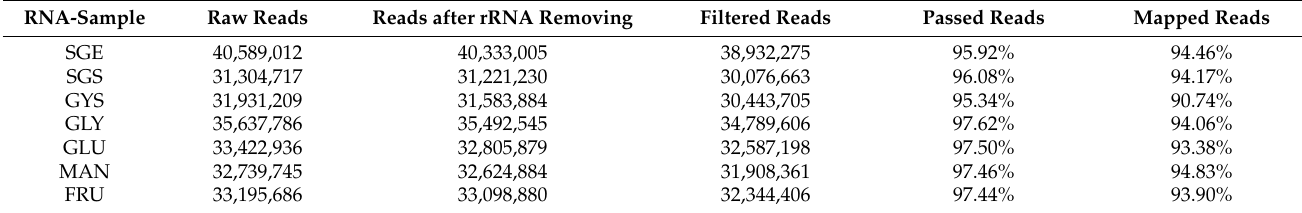
SGE: Solid culture of NA-Glycerol in exponential phase of growth; SGS: Solid culture of NA-Glycerol in stationary phase of growth; GYS: Liquid culture of NB-Glycerol in death phase of growth; GLY: Liquid culture of NB-Glycerol